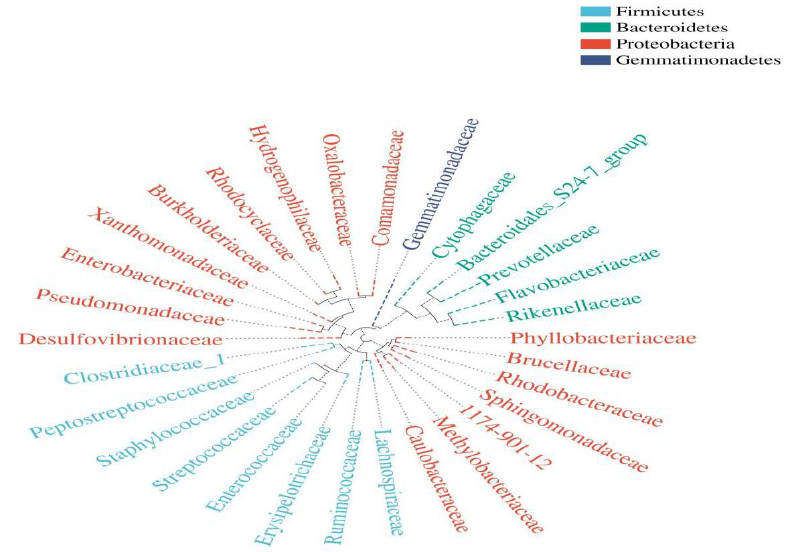
Figure 8. System evolutionary tree of each sample.